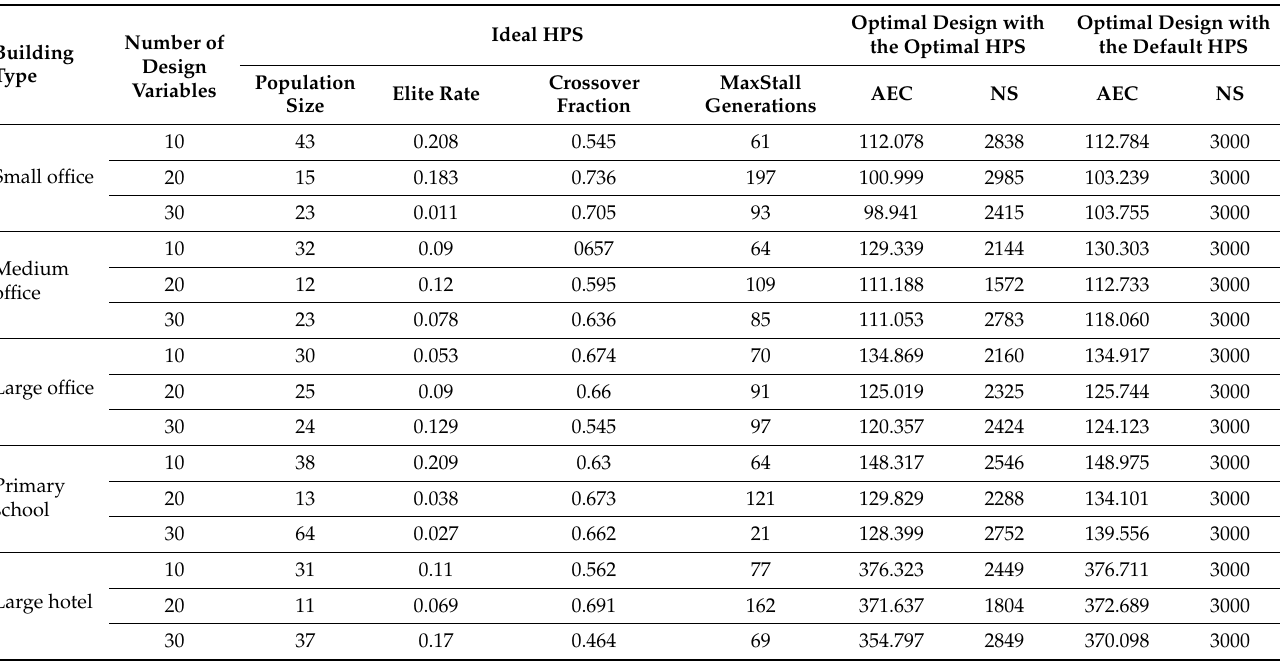
Table 5. Optimal HPSs for the GA.